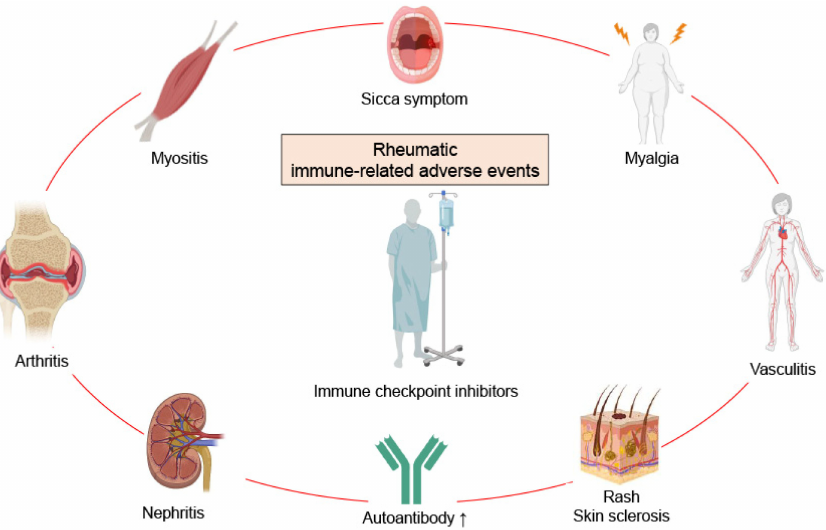
Figure 2. Rheumatic immune-related adverse events show diverse pathologies. Immune checkpoint inhibitors sometimes cause rheumatic-disease-like symptoms called rheumatic immune-related adverse events (irAEs), which involve arthritis, myositis, myalgia, sicca symptoms, a rash, skin sclerosis, nephritis, and vasculitis. Autoantibody production may also be increased. Rheumatic irAEs more commonly occur with anti-programmed cell death protein-1 (PD-1) and anti-programmed cell death ligand-1 (PD-L1) antibodies than anti-cytotoxic T-lymphocyte-associated protein 4 (CTLA-4)